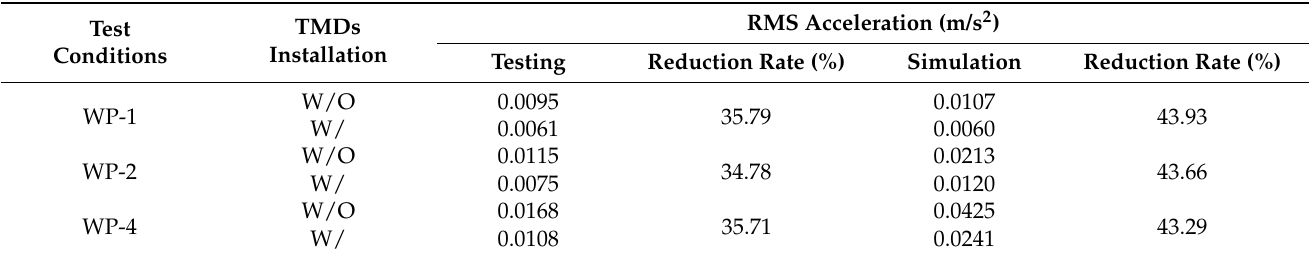
Table 4. Comparison of numerical and measured RMS acceleration of the suspended floor with and without TMDs under pedestrian loads.